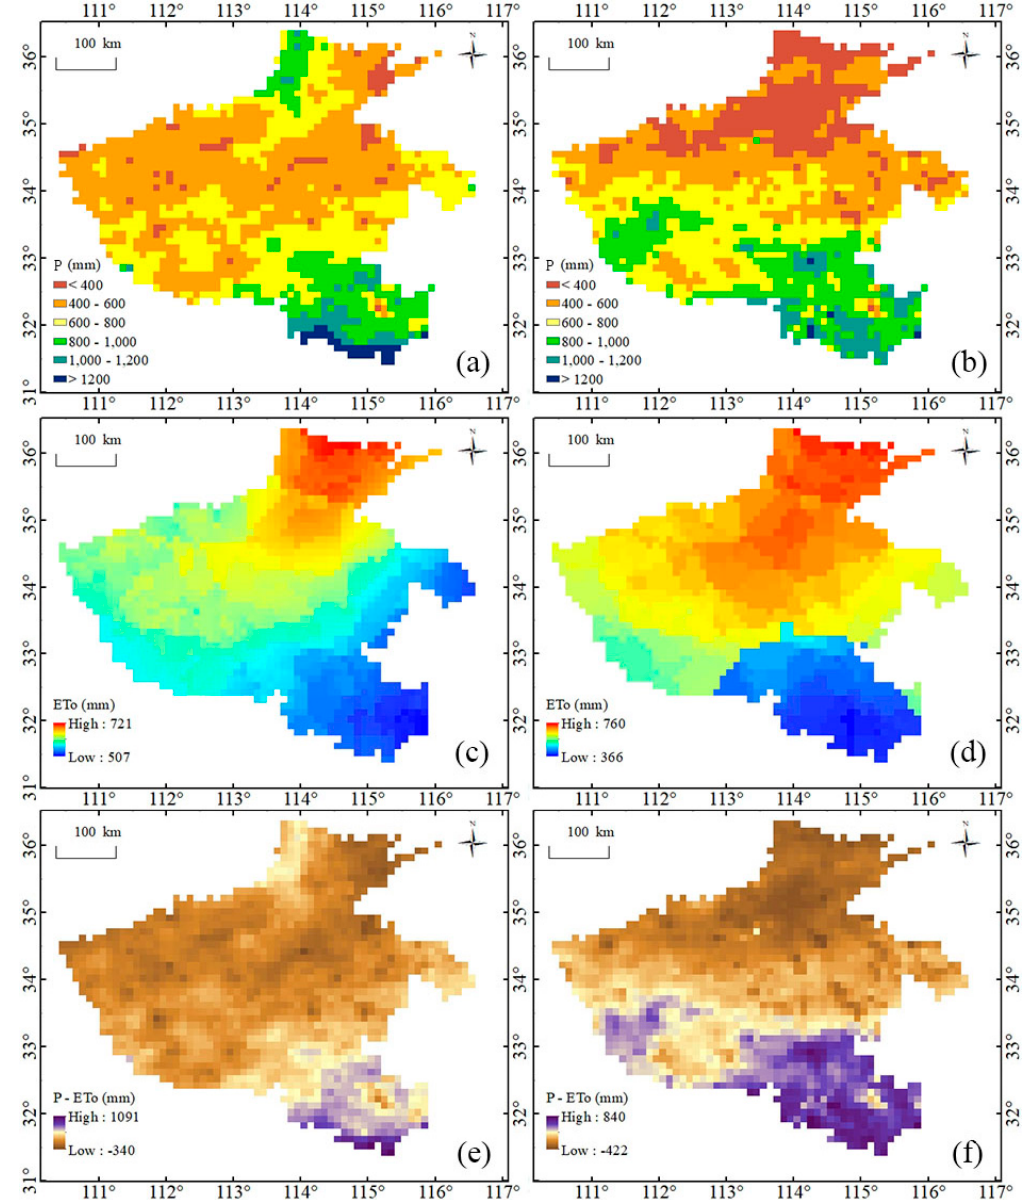
Figure 10 . (a) and (b) show the annual precipitation for 2016 and 2017. (c) and (d) show the annual potential evapotranspiration for 2016 and 2017, calculated using the Penman–Monteith formula (Allen, 1998). (e) and (f) show the difference between the annual precipitation and the annual po- tential